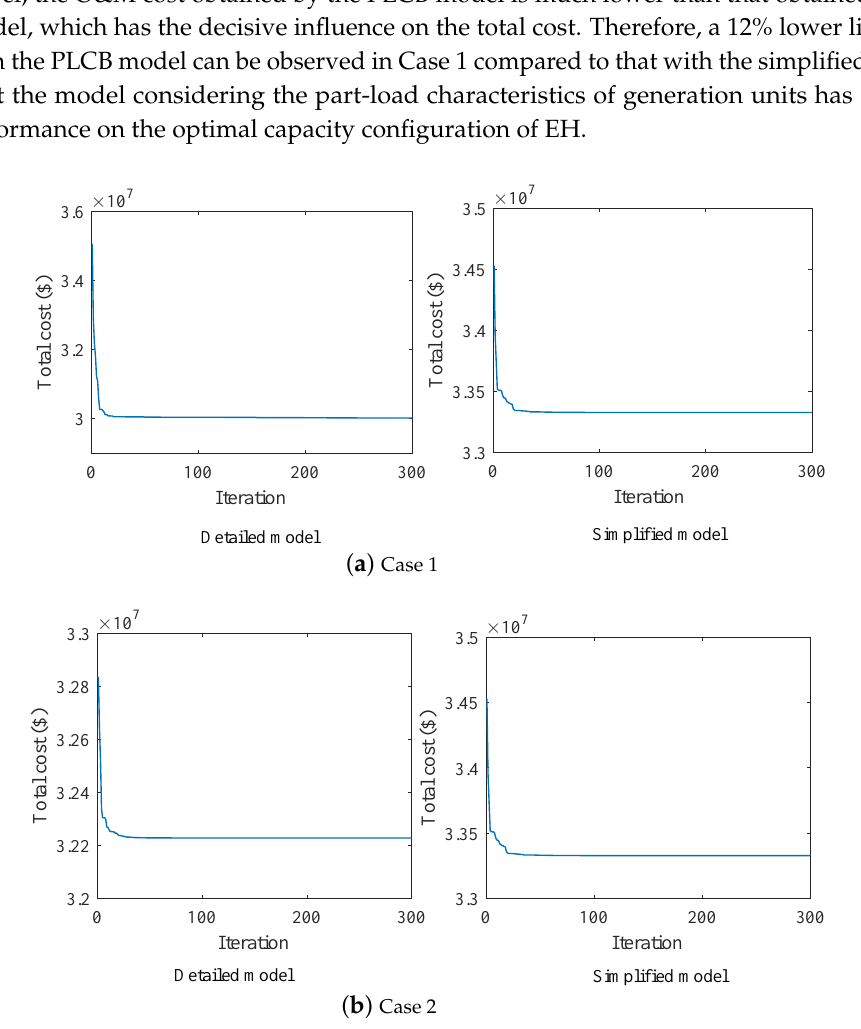
Figure 5. Convergence characteristics of the detailed model and the simplified model for the two